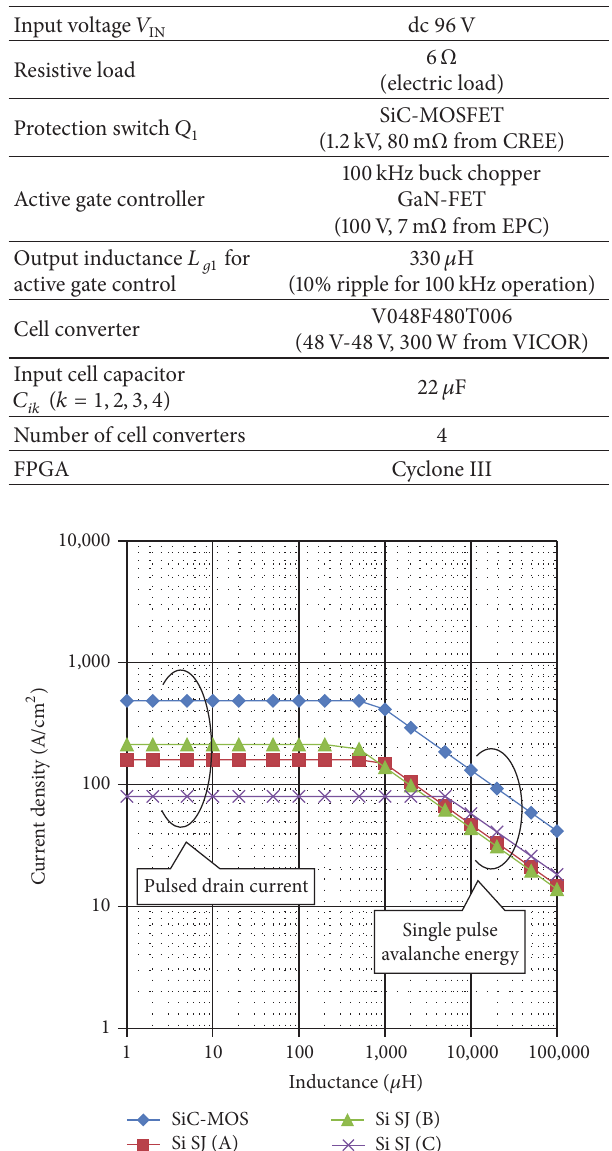
Figure 7: Maximum current density of Si and SiC power devices for safe